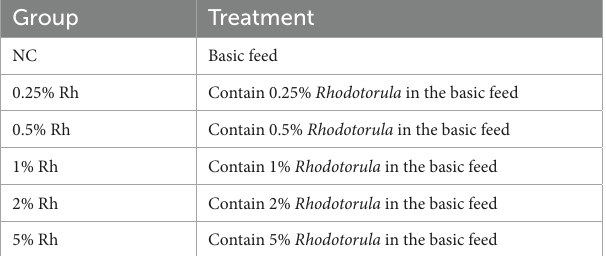
TABLE 2 Groups of laying